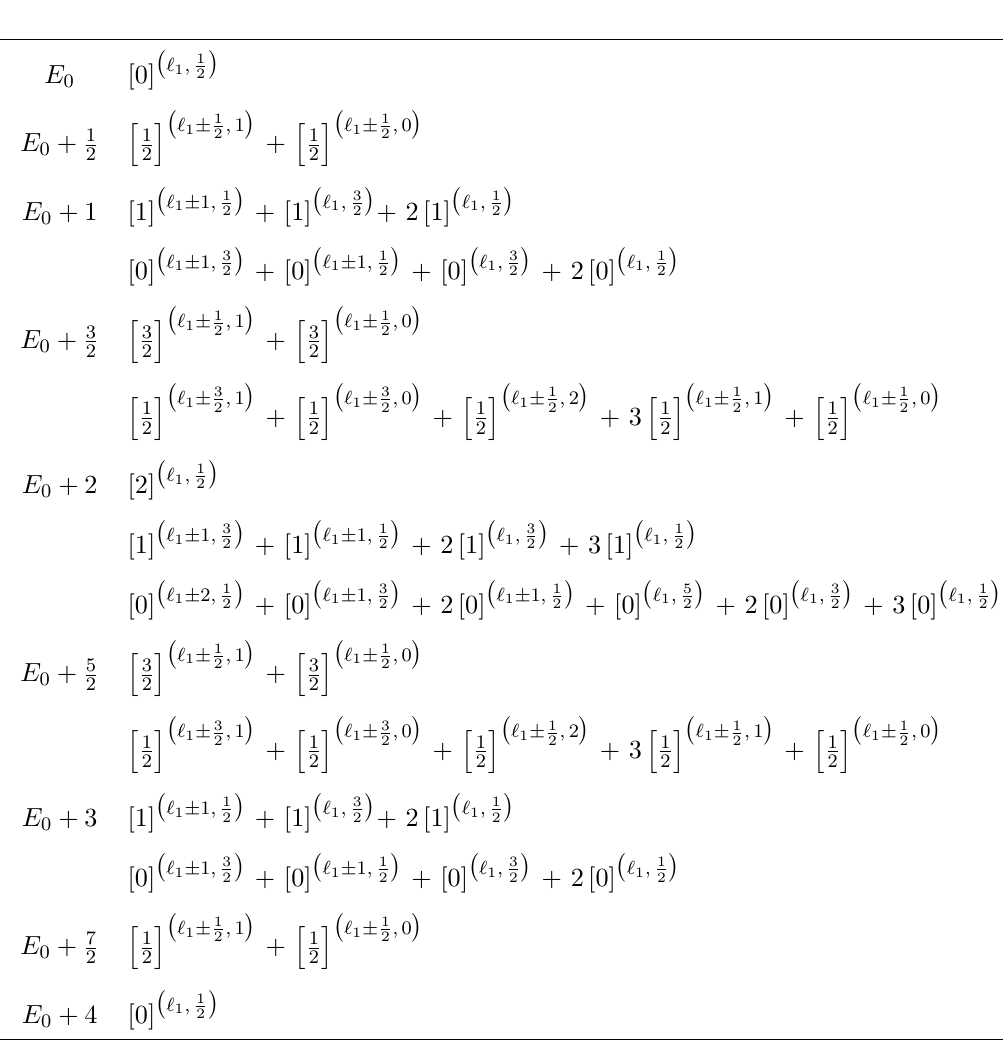
(cid:2) (cid:3) E 0 , ‘ 1 , 1 , with ‘ 1 ≥ 3 . For ‘ 1 = 3 , 2 2 2